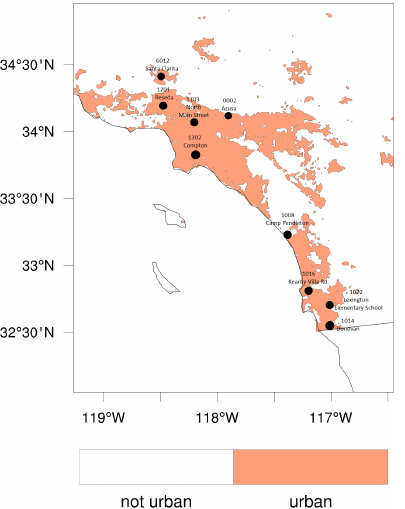
Figure 5. Map of the location of the stations for domain 2.